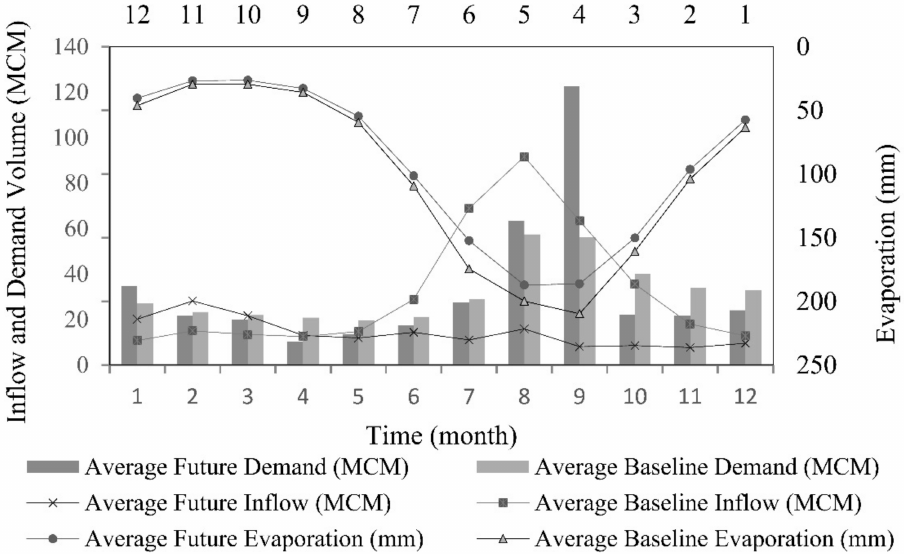
Figure 2. Average monthly inflow volume to the reservoir, average monthly evaporation depth, and the average monthly volume of water demand in the baseline and under climate change